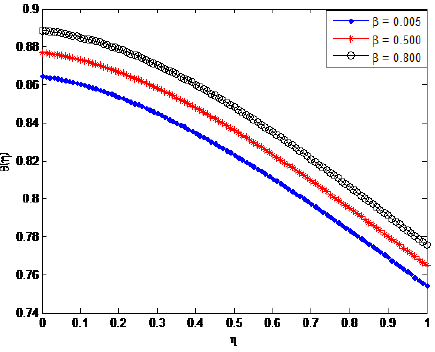
Figure 13. Influence of the third grade fluid parameter on Dimensionless temperature profile